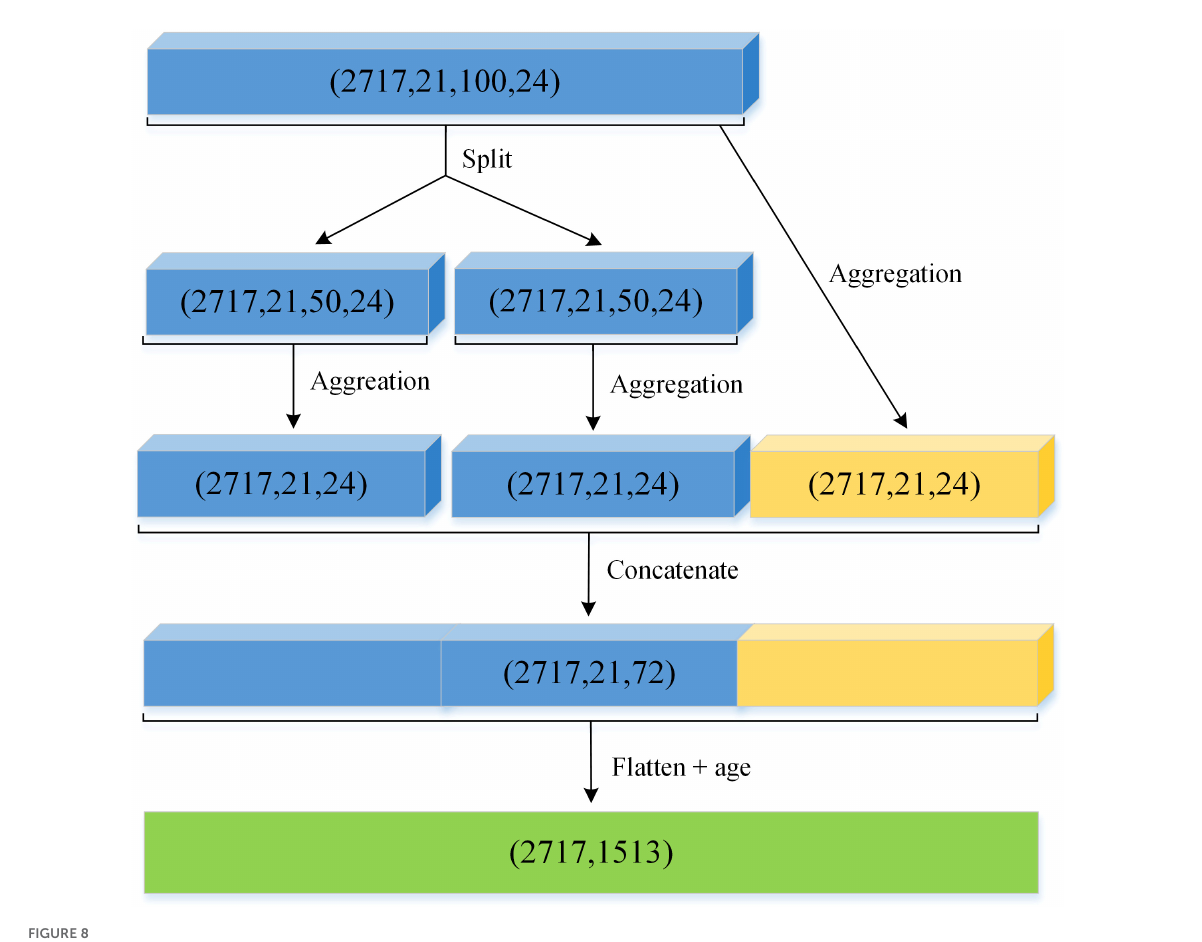
FIGURE8 The process of the salient feature extraction for EEG pathology